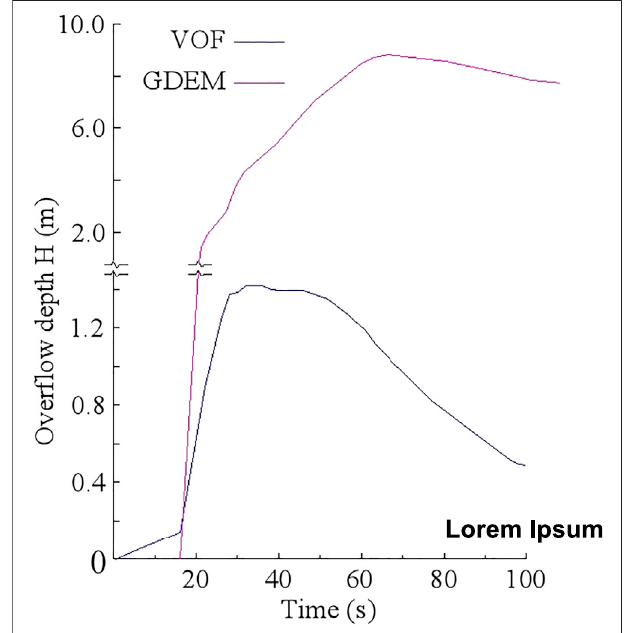
FIGURE 14 | The comparison of comprehensive buildings over fl ow